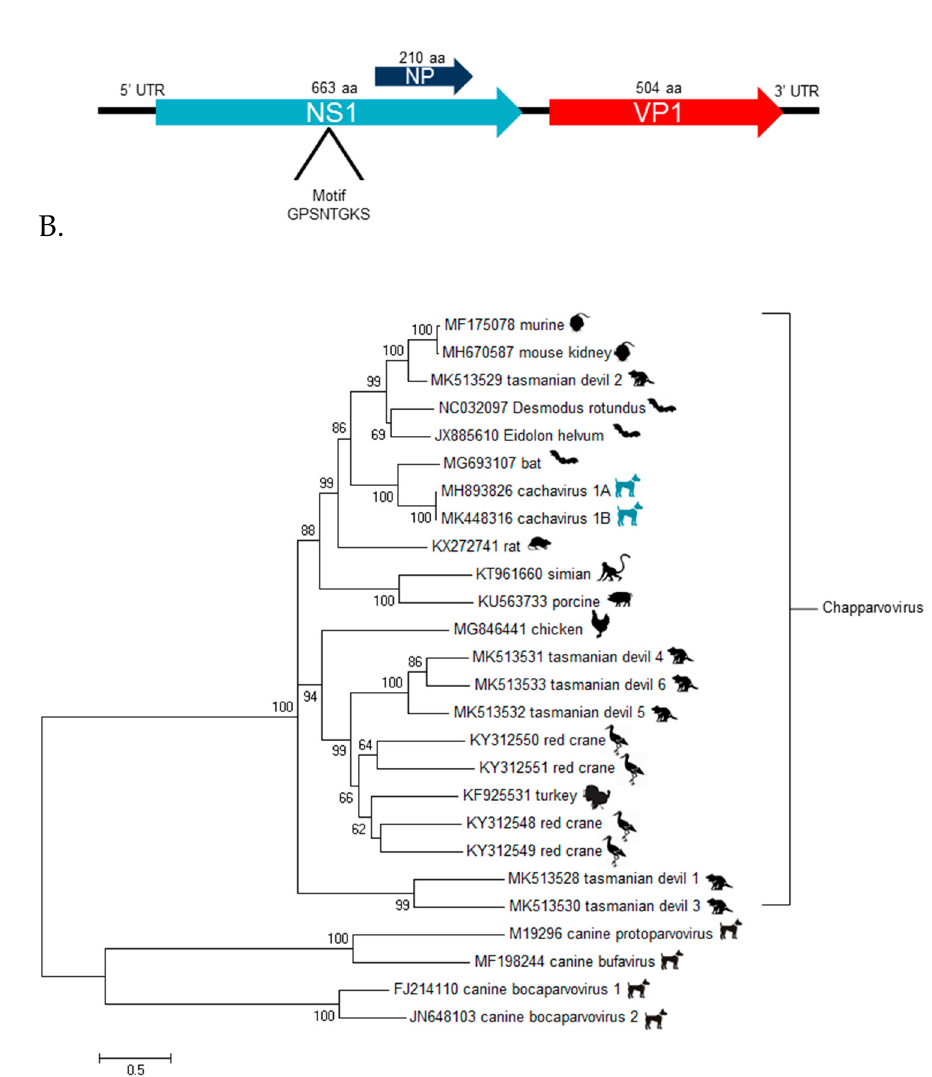
Figure 1. ( A ) ORF map and location of nucleotide-binding Walker loop motif. (B) Maximum likelihood tree of NS1 aa sequences of chapparvoviruses. Bar, 0.5 amino acid substitutions per site. Bootstrap values below 60 were removed.